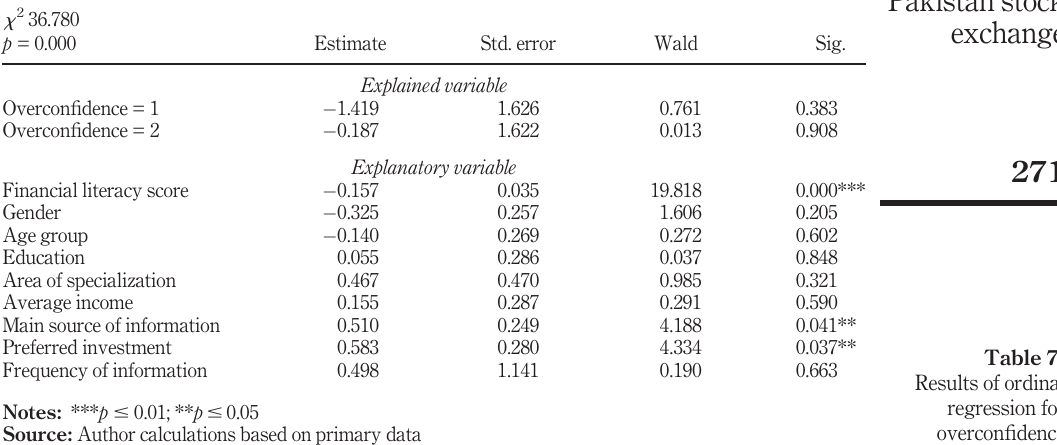
Table 7. Results of ordinal regression for overcon fi dence